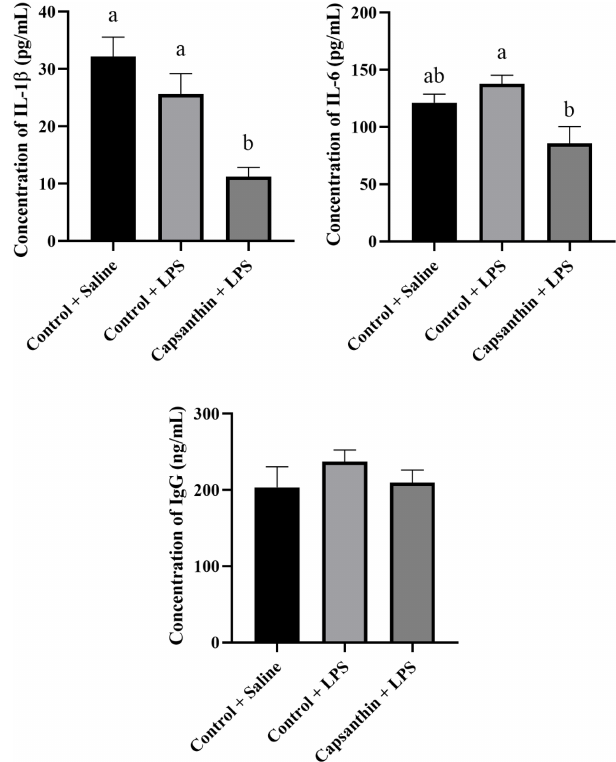
Figure 3. Concentrations of plasma interleukin-1 β (IL-1 β ), interleukin-6 (IL-6), and immunoglobulin G (IgG) of broiler